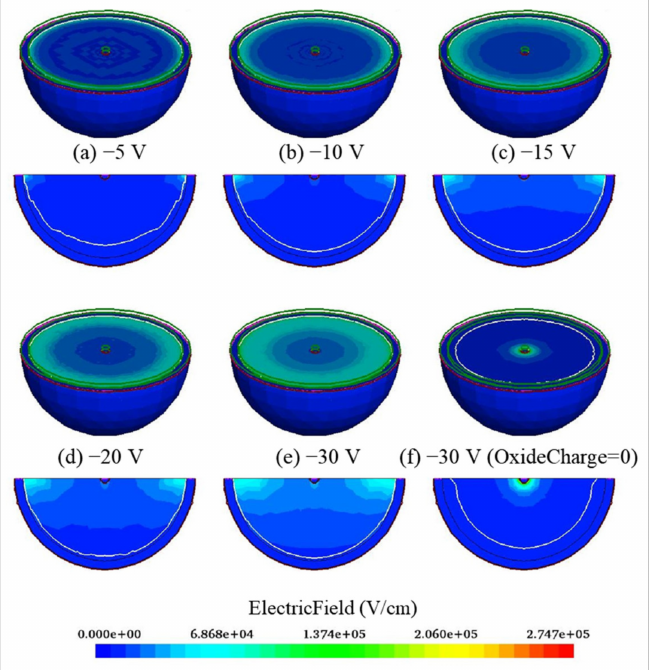
Figure 3. 3D and 2D electric field distributions with different bias